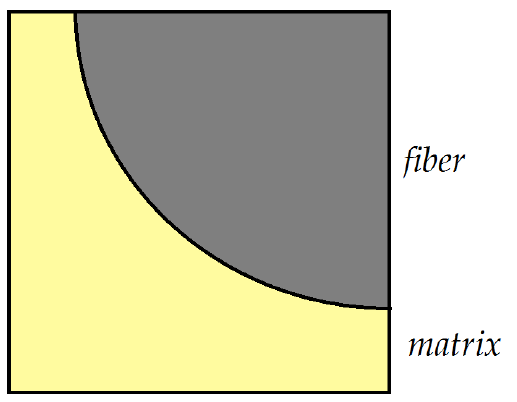
Figure 6. Finite element model 1 for a RUC.